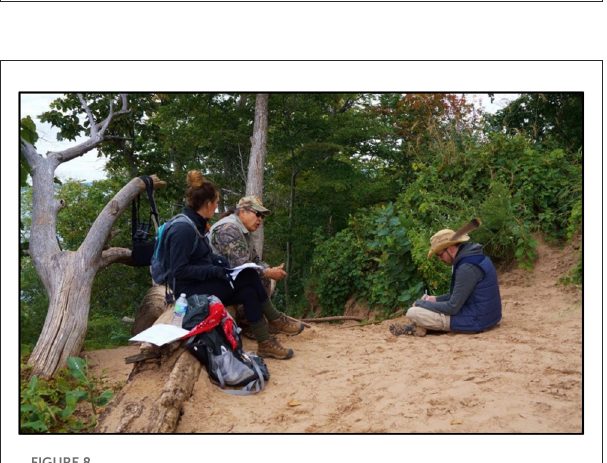
FIGURE8 Talking about dune-forests at pyramid point.